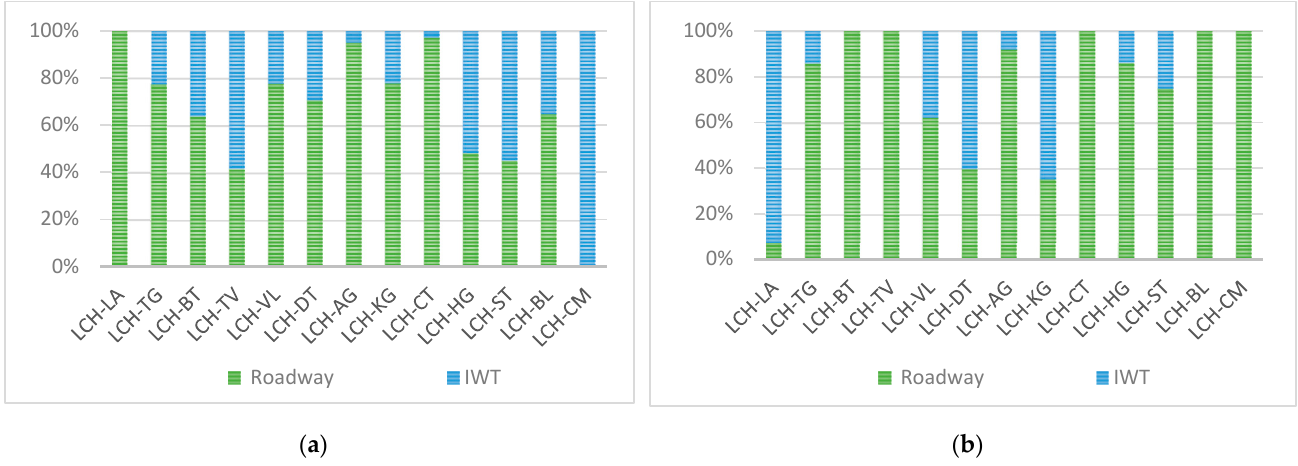
Figure 7. Proportion of transport modes at local collection hubs. ( a ) Receiving flow; ( b ) shipping flow.